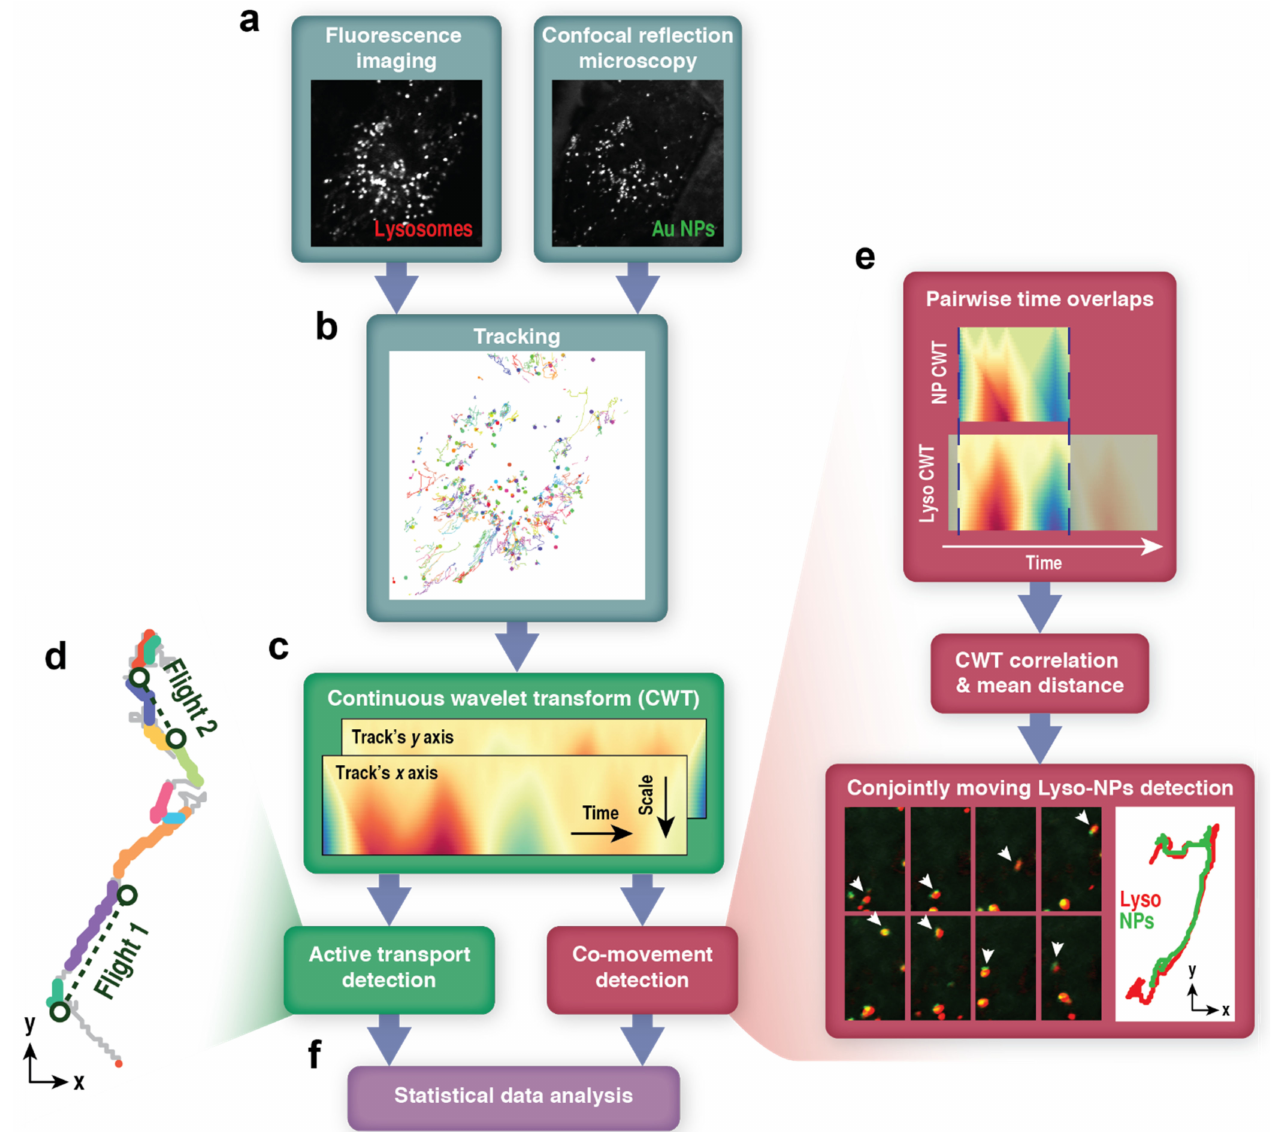
Figure 1. Schematic of the analysis of lysosome movement patterns and lysosome-nanoparticle co- transport. ( a ) A snapshot of a time-series of an MCF-10A cell with lysosomes marked by Lysotracker Red and imaged with fluorescence and gold nanoparticle aggregates (Au NPs) imaged label-free in confocal reflection mode (CRM). See also Supplementary Movies S1 and S2. ( b ) Both lysosomes and Au NP aggregates are tracked by a single-particle tracking module in NIS-Elements software. ( c ) Multiscale wavelet coefficients are computed by continuous wavelet transform (CWT) for x and y coordinates of trajectories. ( d ) Shows an example of lysosome trajectory segmented using CWT-based active transport detection. The color indicates intervals of diffusive motion (grey) and directional, active transport—several “runs” (colored) that often join to form directional “flights” (dashed lines connect the beginnings with ends of such flights). ( e ) CWT results are also used to detect co-transported lysosomes and Au NP aggregates. ( f ) Classifications performed by the previous stages of the workflow are used in the statistical data analysis, investigating lysosome mean square displacements (MSD) and persistence lengths for runs ( l ) and flights ( L ). See the Section 2 for more